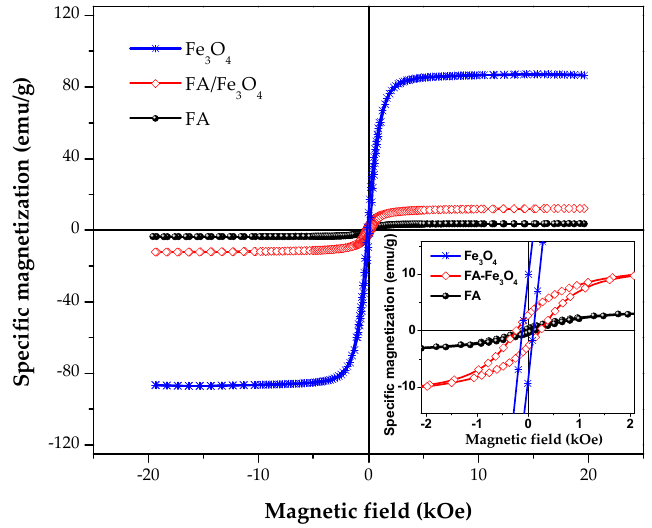
Figure 6. Magnetization hysteresis loop of the FA/Fe 3 O 4 vs. FA.